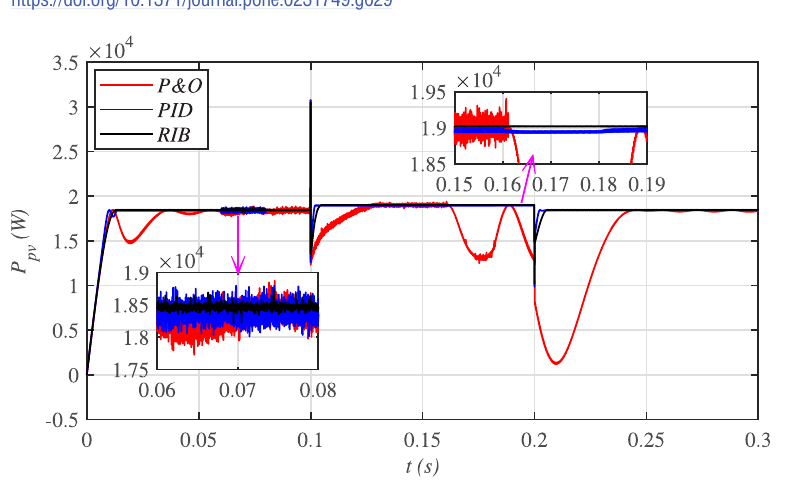
Fig 30. PV array comparative powers under uncertainties and varying meteorological conditions.